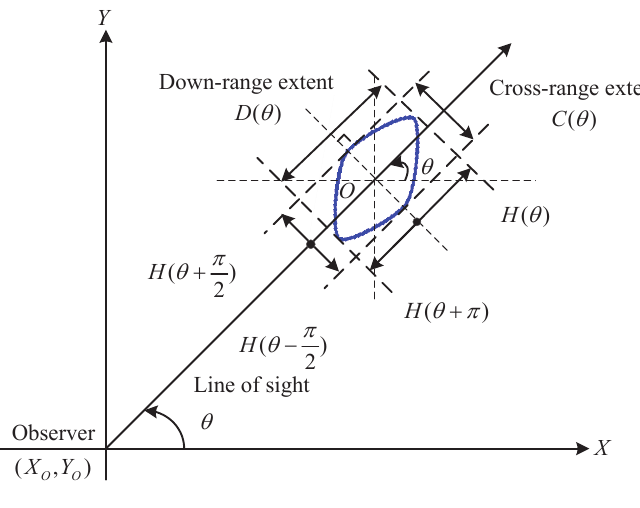
Figure 1. Down-range and cross-range